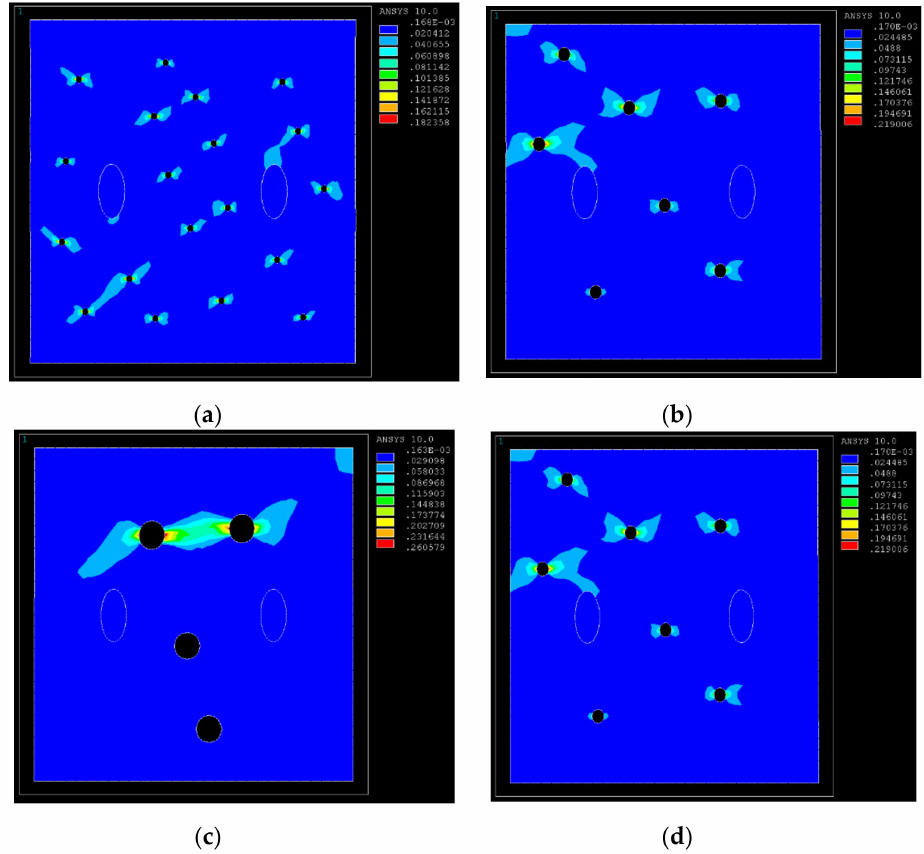
Figure 6. Strain diagrams of GRANs with different pore sizes, ( a ) 0.5 µ m, ( b ) 1 µ m, ( c ) 2 µ m, and ( d ) 3 µ m.